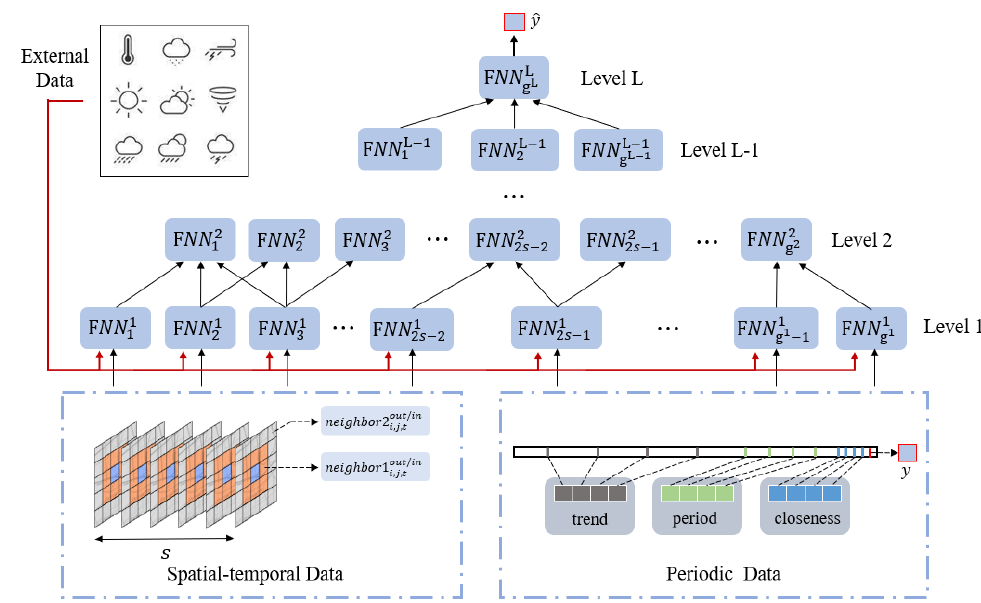
Figure 8. Overall framework of SCDFNN.